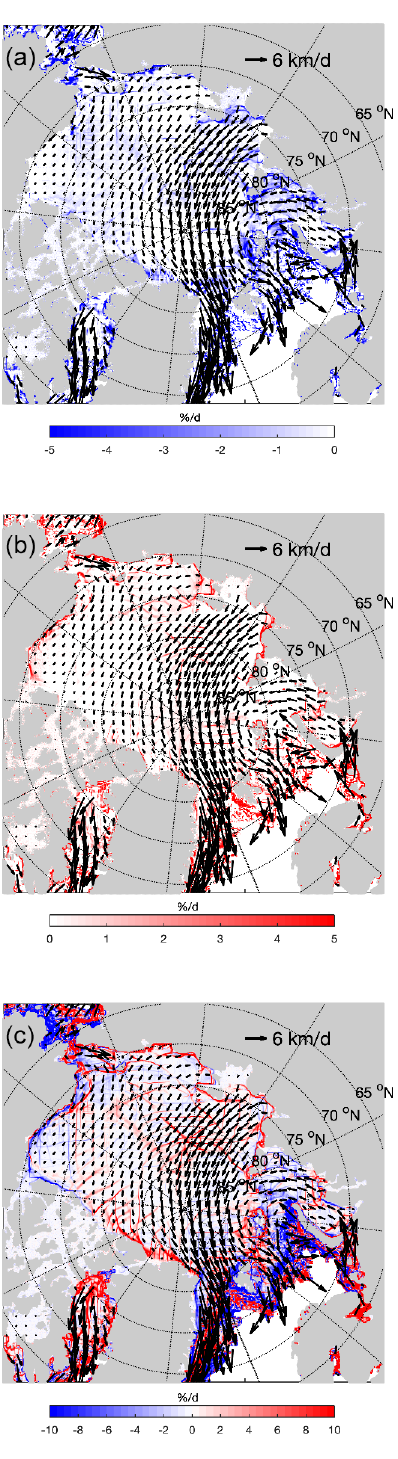
Figure 10. Sea ice anomalies calculated from the RASM hindcast simulation for January–March (JFM) 2020 compared to the RASM climate mean for JFM 2010–2019 for negative divergence ( a ; blue shading represents less divergence) and positive divergence ( b ; red shading represents more divergence). Panel (c) displays ice shear anomalies (%d − 1 ). The mean velocity vectors for the same period of JFM 2020 are overlaid in each plot.